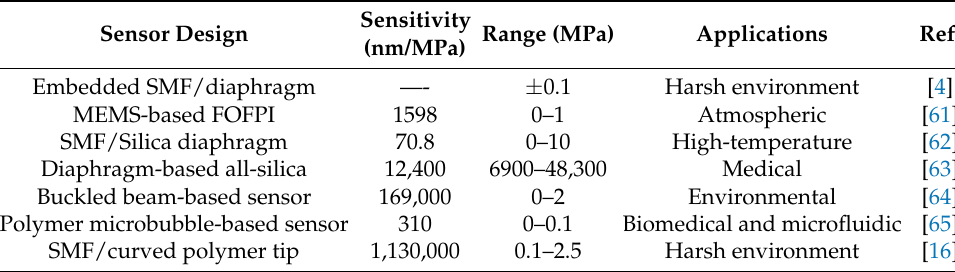
Table 2. Pressure sensitivity of FOFPI.